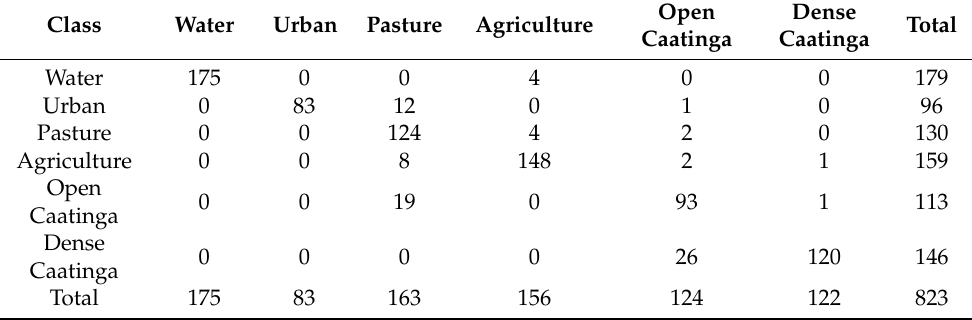
Table A3. Confusion matrix year 2018.